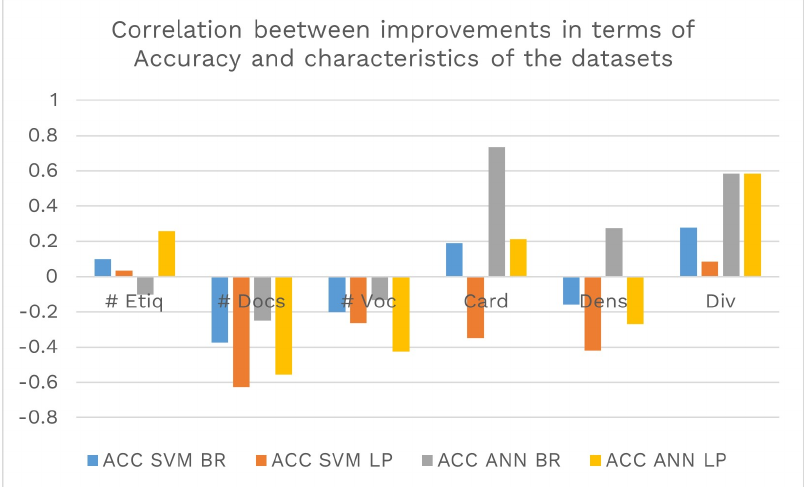
Figure 6. Correlation between performance improvements in terms of Accuracy and the different characteristics of the data set (number of labels, number of documents, number of vocabulary terms, cardinality, density, and